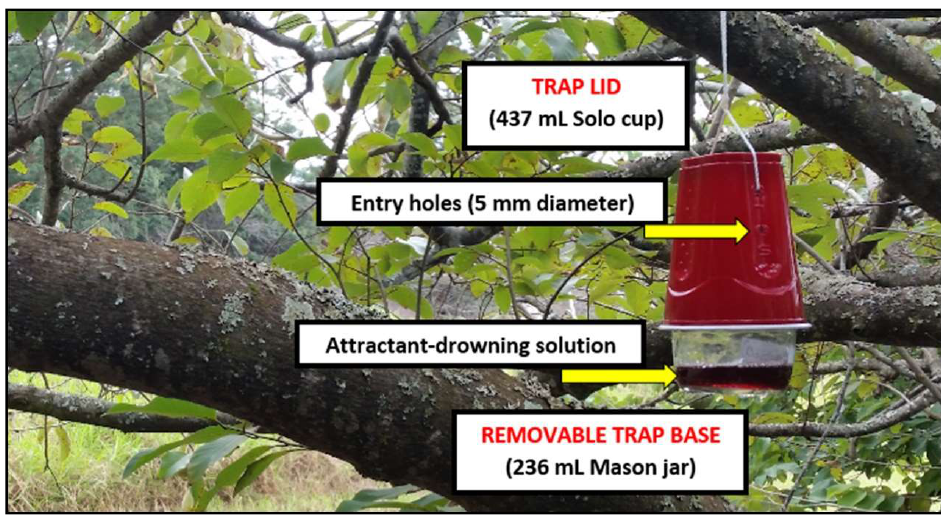
Figure 1. Assembled trap hanging in a cherimoya tree.